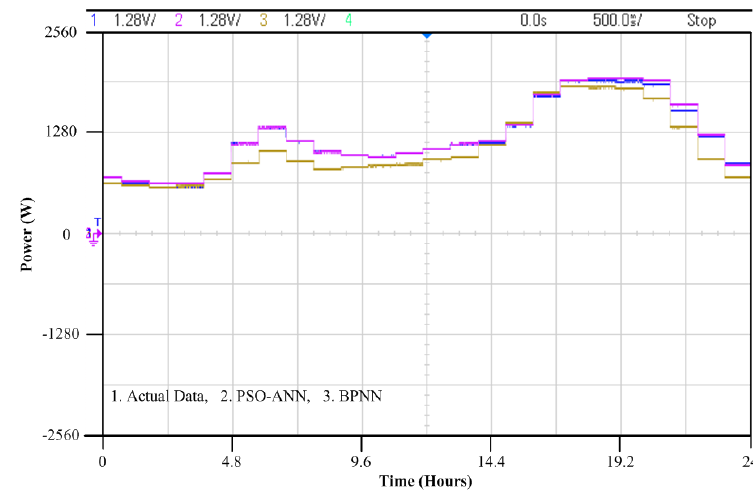
Figure 9. Forecasting result of load demand with PSO-ANN and BPNN.